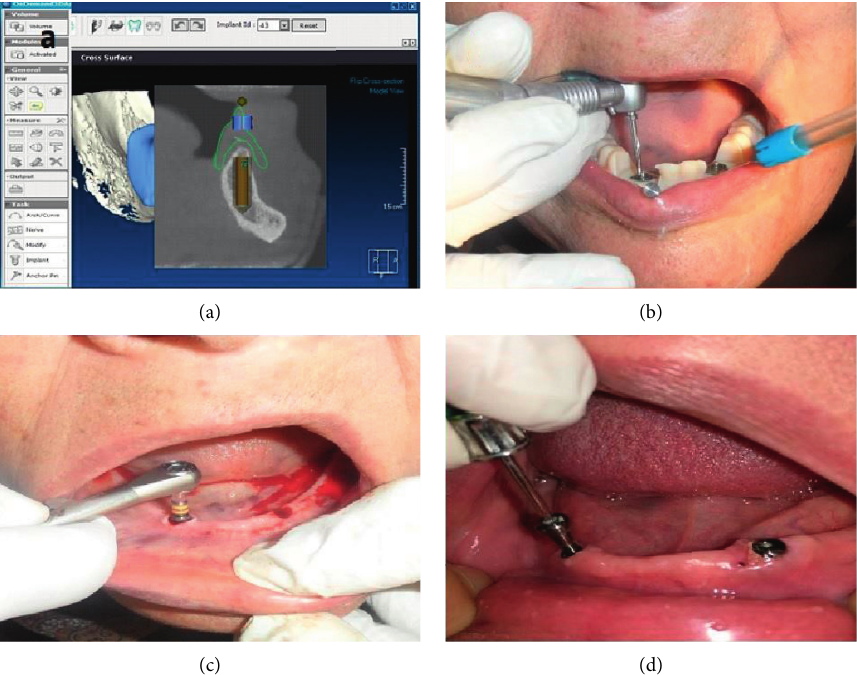
Figure 1: Surgical procedures for fixture mounting; (a) virtual planning (sagittal view); (b) drilling sequence through mounted surgical guide; (c) fixture mounting; (d) screwing of healing abutments.